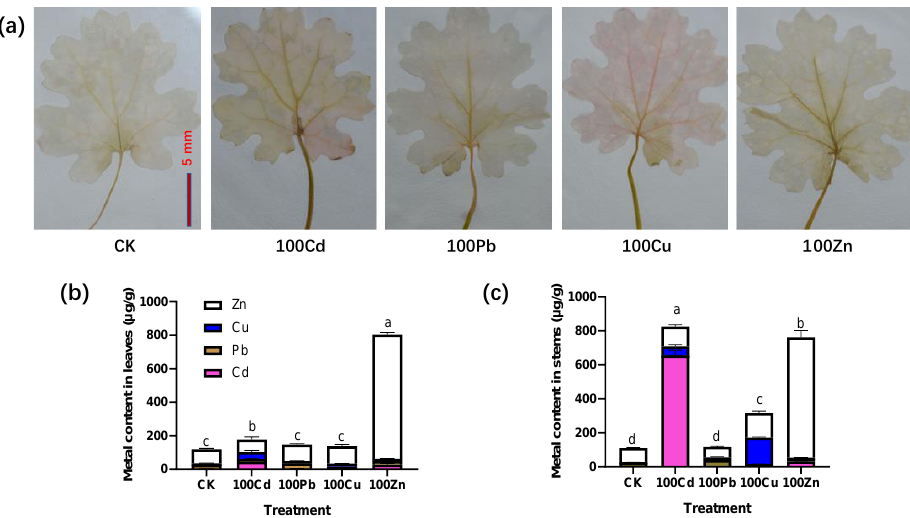
Figure 5. Dithizone staining ( a ) and metal content in leaves ( b ) and stems ( c ) of M. cordata under control (CK) and 100 µ mol · L − 1 Cd, Pb, Cu, and Zn after 20 days of exposure. Staining experiments were repeated at least five times with similar results. Bar, 5 mm. Values are means ± SEs ( n = 3) of three different experiments. Means denoted by different letters refer to the significant differences ( p < 0.05, Duncan’s test).